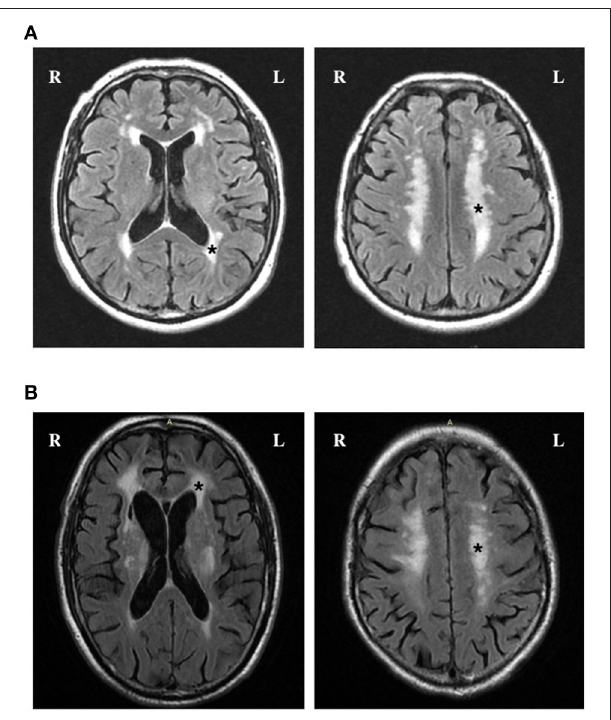
FIGURE 1 | FLAIR images of high total WMH burden in patients with elevated TMAO levels. (A) and (B) Axial FLAIR slices show the position of periventricular (left) and deep WMH (right). Fazekas scores in periventricular region and deep region were both rated as grade 3 ( * ) in a patient with 5.3 µ mol/L TMAO (A) and 5.4 µ mol/L TMAO (B)